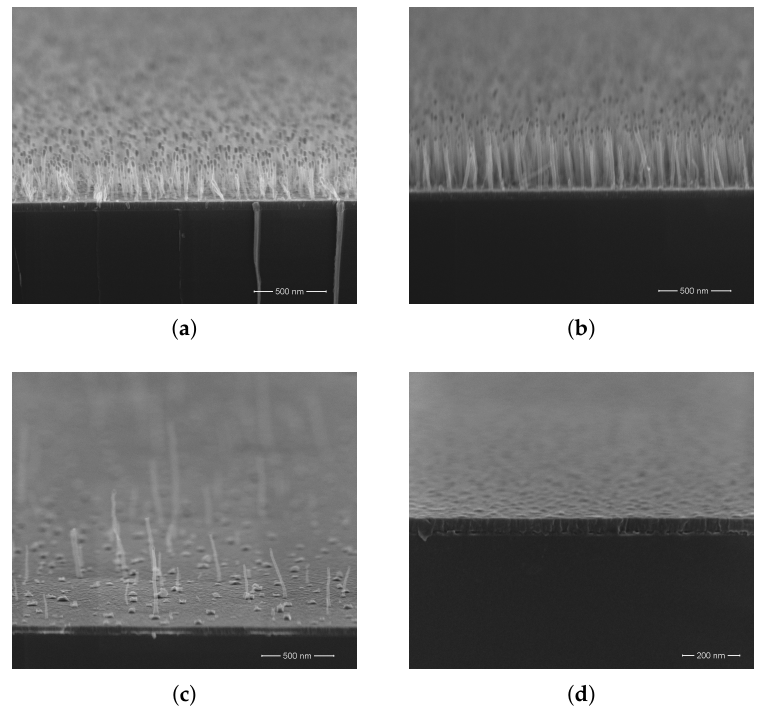
Figure 6. Cross-section SEM micrographs at ( a – c ) 100,000 × and ( d ) 200,000 × magnification of CNT samples grown with a fixed CH 4 :NH 3 = 70:50 sccm gas flow ratio at ( a ) 750 ◦ C, ( b ) 800 ◦ C, ( c ) 850 ◦ C, and ( d ) 900 ◦ C for 1